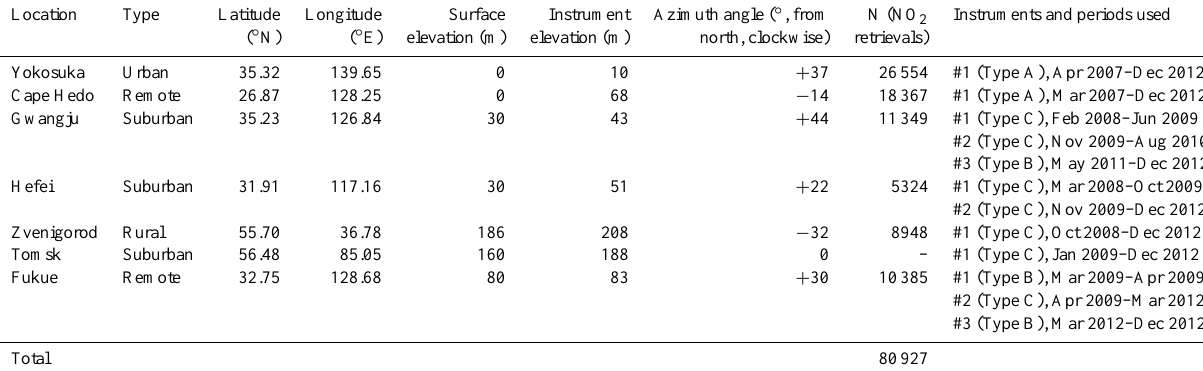
Table 1. List of locations for MAX-DOAS observations.